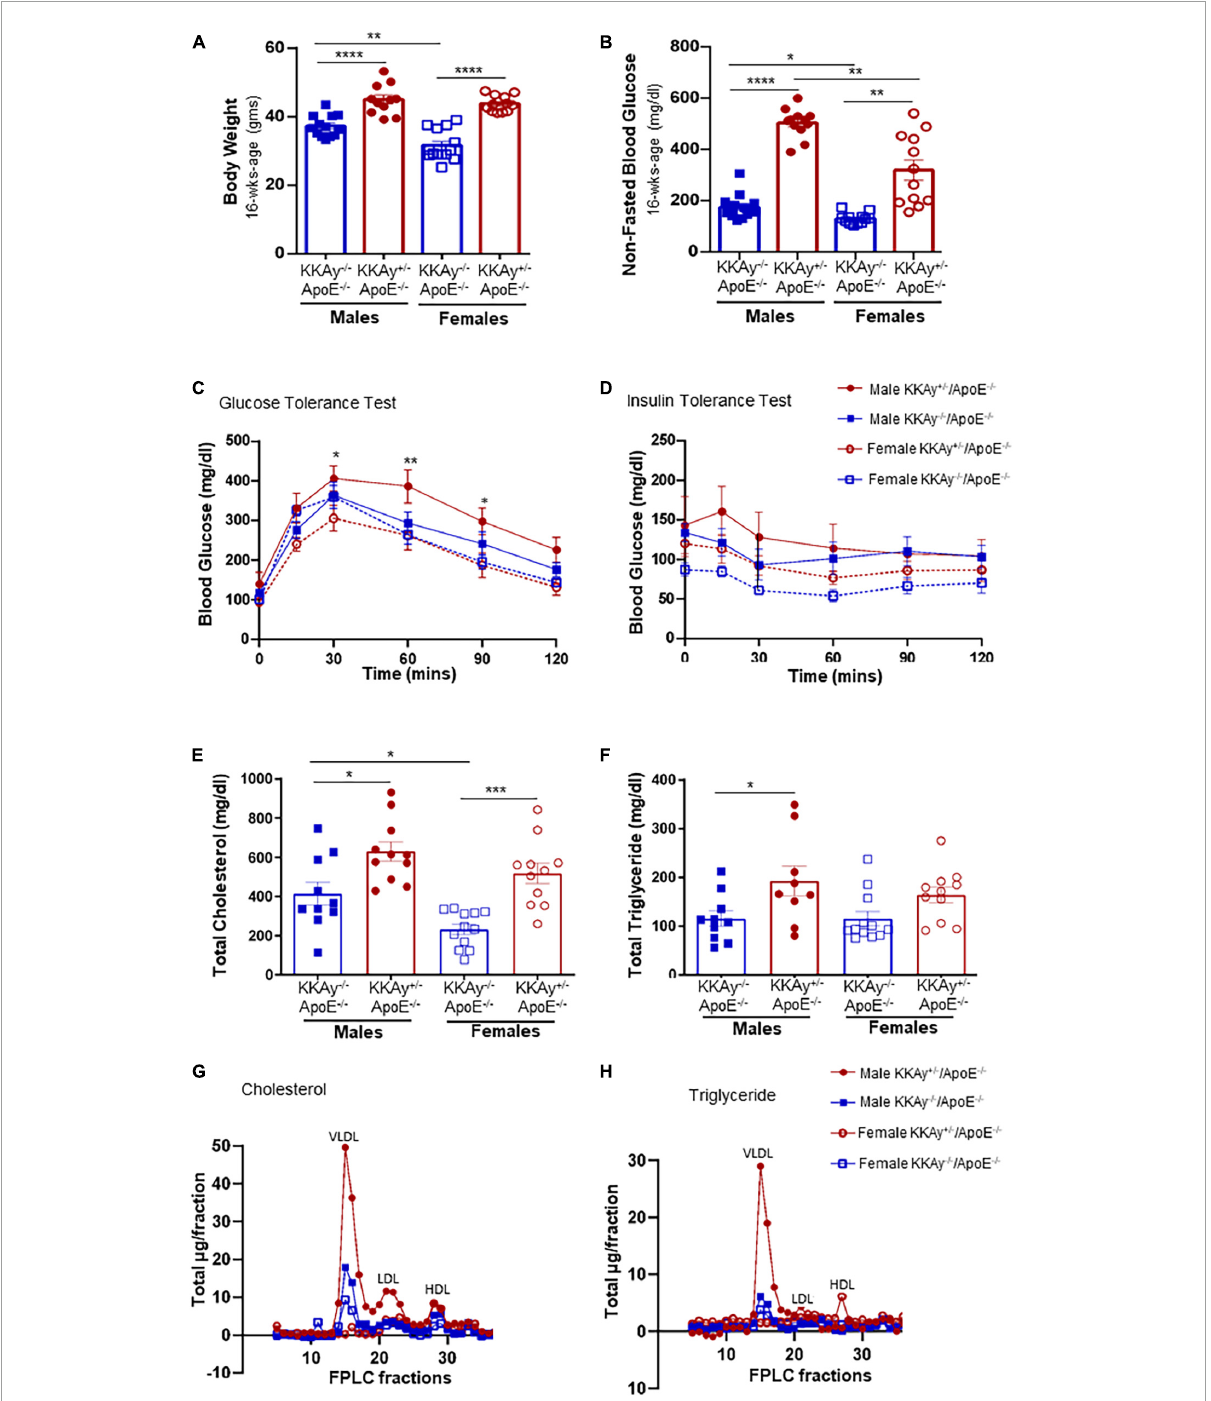
FIGURE1 Sex-based differences in metabolic profile of agouti KKAy + / − ApoE − / − and non-agouti KKAy − / − ApoE − / − mice. Male and female age-matched KKAy + / − ApoE − / − and KKAy − / − ApoE − / − littermate mice were maintained on standard laboratory diet from 4 to 24 weeks of age. At 22 weeks of age, subsets of mice were subjected to either intraperitoneal glucose tolerance test (GTT) or insulin tolerance test (ITT) followed by mice harvest at 24 weeks age for blood and tissue collection. Shown are (A) body weight at 16 weeks age; (B) non-fasted blood glucose at 16 weeks age; (C) glucose tolerance test (GTT) * p < 0.05 and ** p < 0.01 for male KKAy + / − ApoE − / − vs. female KKAy + / − ApoE − / − ; (D) insulin tolerance test (ITT); (E) plasma total cholesterol; (F) plasma total triglyceride; (G) cholesterol lipoprotein distribution via FPLC fractionation; (H) triglyceride lipoprotein distribution via FPLC fractionation. Results are expressed as mean ± SEM. For panels (A,B,E,F) **** p < 0.0001, *** p < 0.0005, ** p < 0.005, * p < 0.05. n =